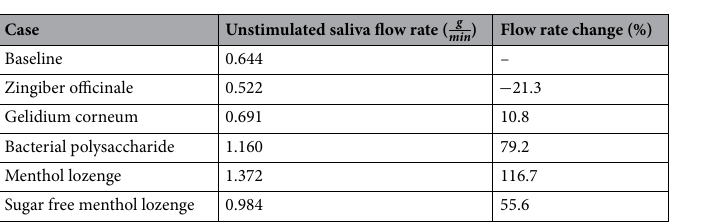
Table 2. Unstimulated, saliva flow rate average over 10